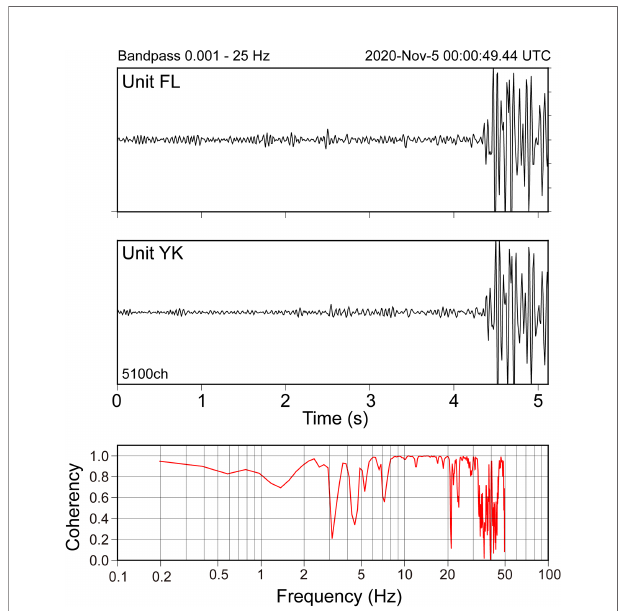
FIGURE 9 | Comparison of the records of airgun signals by two identical interrogators using a different fi ber in the same sea fl oor cable. A bandpass fi lter from 1,000 s to 25 Hz was applied. The large amplitude of both records indicates arrivals of direct water waves from airguns. Coherency between both the records was calculated (lower). High coherency was generally obtained; however, the coherency at some frequencies was